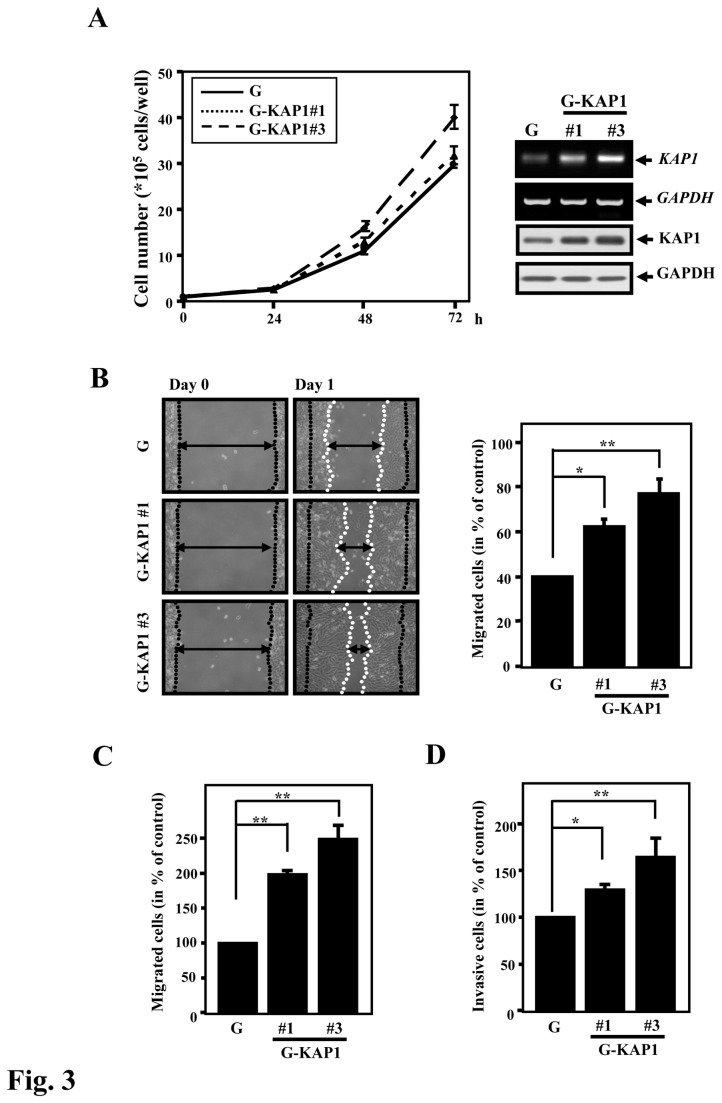
KAP1 enhances cell migration and invasion.
A, Right, HeLa cells were stably transfected with EGFP-KAP1 expression constructs. KAP1 mRNA and protein levels were assessed by reverse transcription-PCR and Western blotting. Left, KAP1 expression scarcely induced cell proliferation. Equal numbers of EGFP (G) or EGFP-KAP1 (G-KAP1#1 or G-KAP1#3) HeLa cells were seeded, and the viable cell number was determined at the indicated times. B, The wound-healing migration assay was performed with the control and stable KAP1-expressing cells. The cell-free gap (i.e., the “wound”) was created using a culture insert. Representative images of wound sealing were collected on day 0 and the next day (day 1). Right, the level of cell migration into the gap quantified as the percentage of wound sealing. Columns, the average of three independent measurements; bars, mean ± SD. **p<0.01; *p<0.05. C, KAP1 enhances the migration of cancer cells. Cells were seeded in a transwell chamber, and the level of cell migration was determined. D, KAP1 enhances the invasiveness of cancer cells. Cells were seeded in a BD matrix gel layer, and the level of cell invasion was determined using CyQUANT NF dye, as described in the Materials and Methods. Columns, the average of three independent measurements; bars, mean ± SD. **p<0.01; *p<0.05.